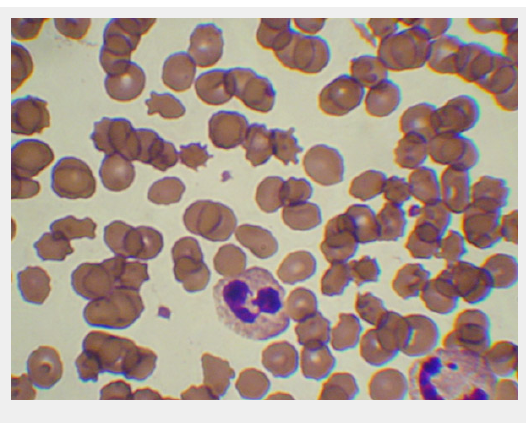
Chorea-acanthocytosis: acanthocytic (A) and echinocytic (E) deformation of RBCs.